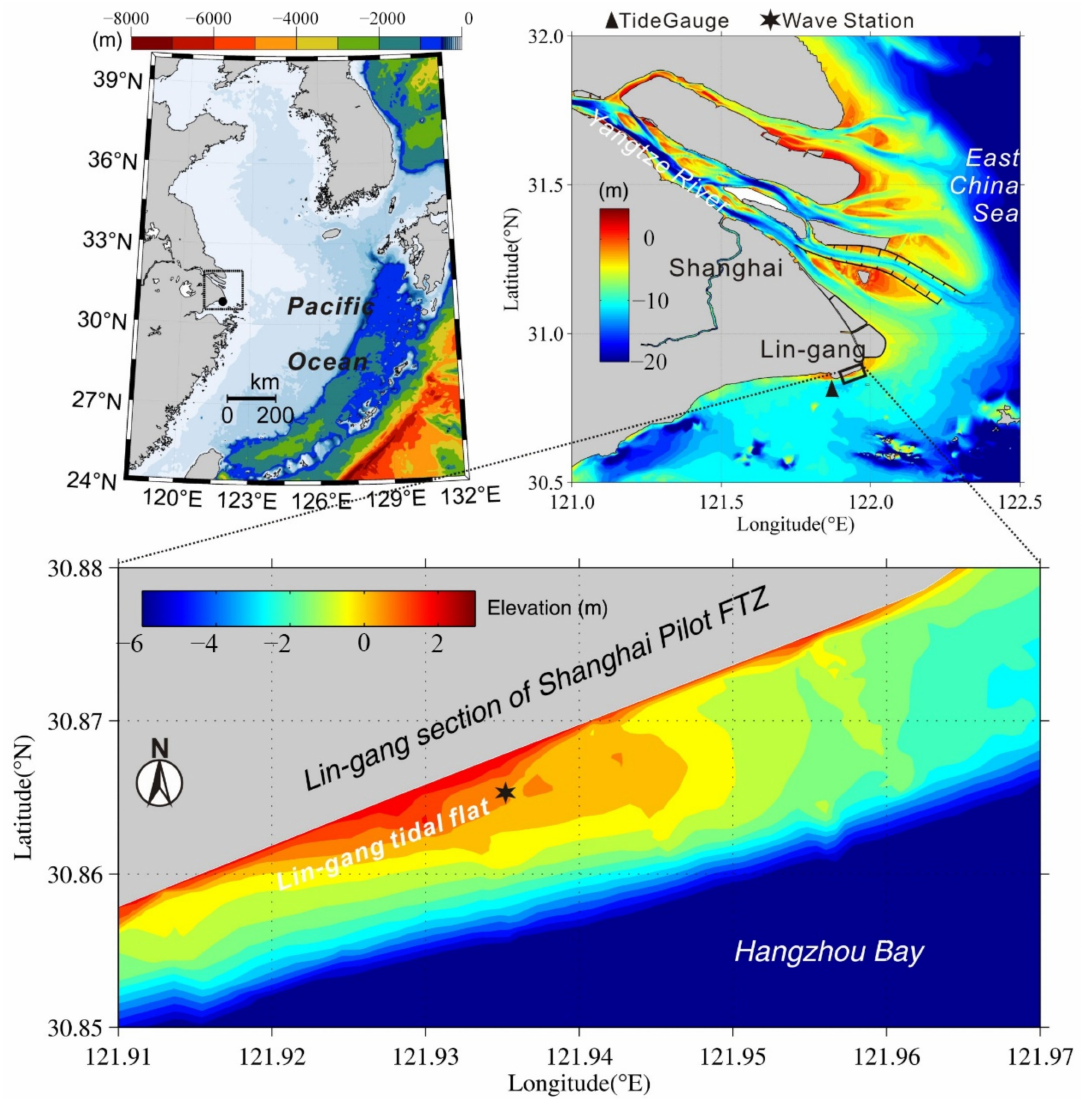
Figure 1. The location and topography of the study area. The study area is adjacent to the Yangtze (Changjiang) River Estuary and Hangzhou Bay. The base level of the elevation datum is the local mean sea level. The triangle and star symbols represent the locations of the tide gauge and wave monitoring station,